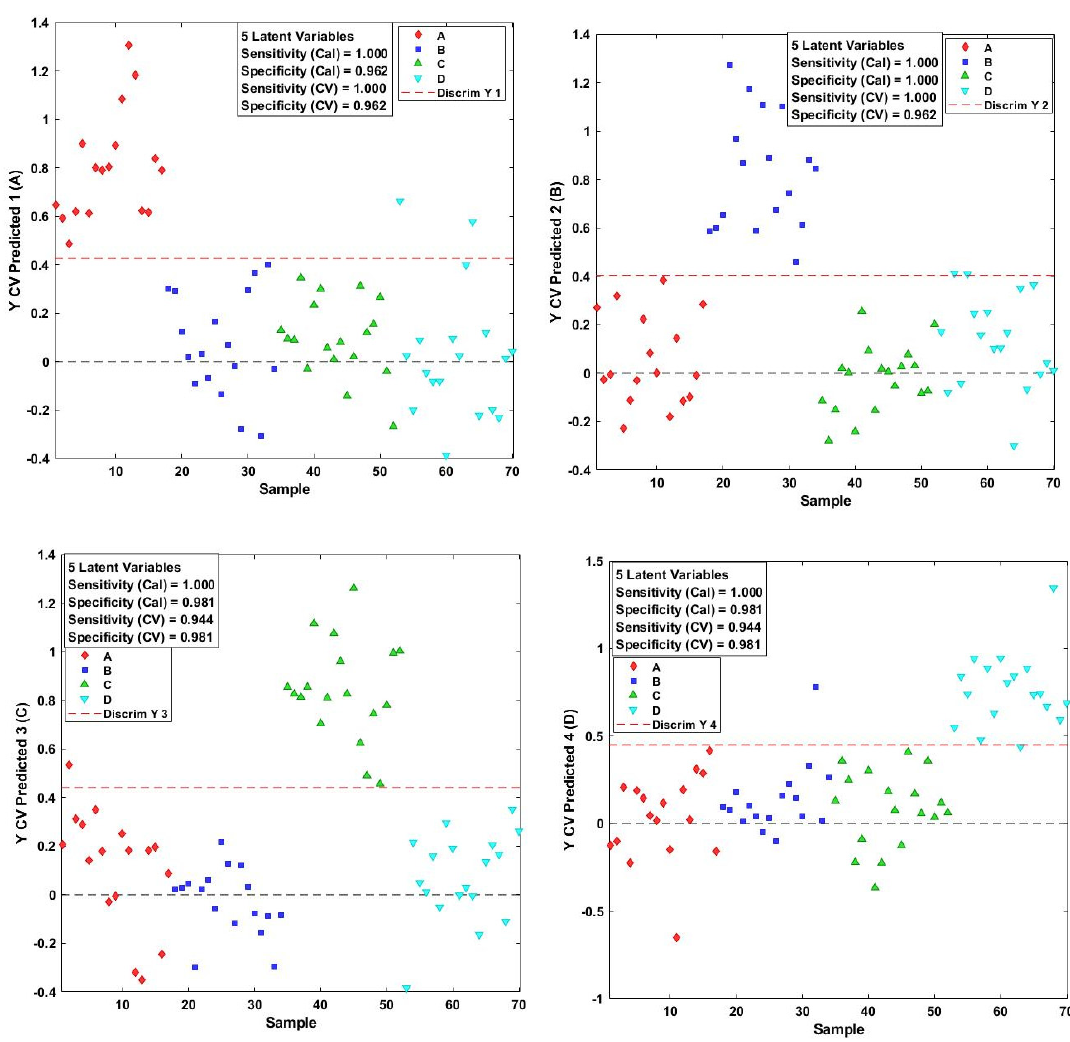
Figure 2. PLS-DA results obtained from spectroscopic measurements of the 4 brands of lutefisk. Reproduced in compliance with CC BY license from Ref. [24].